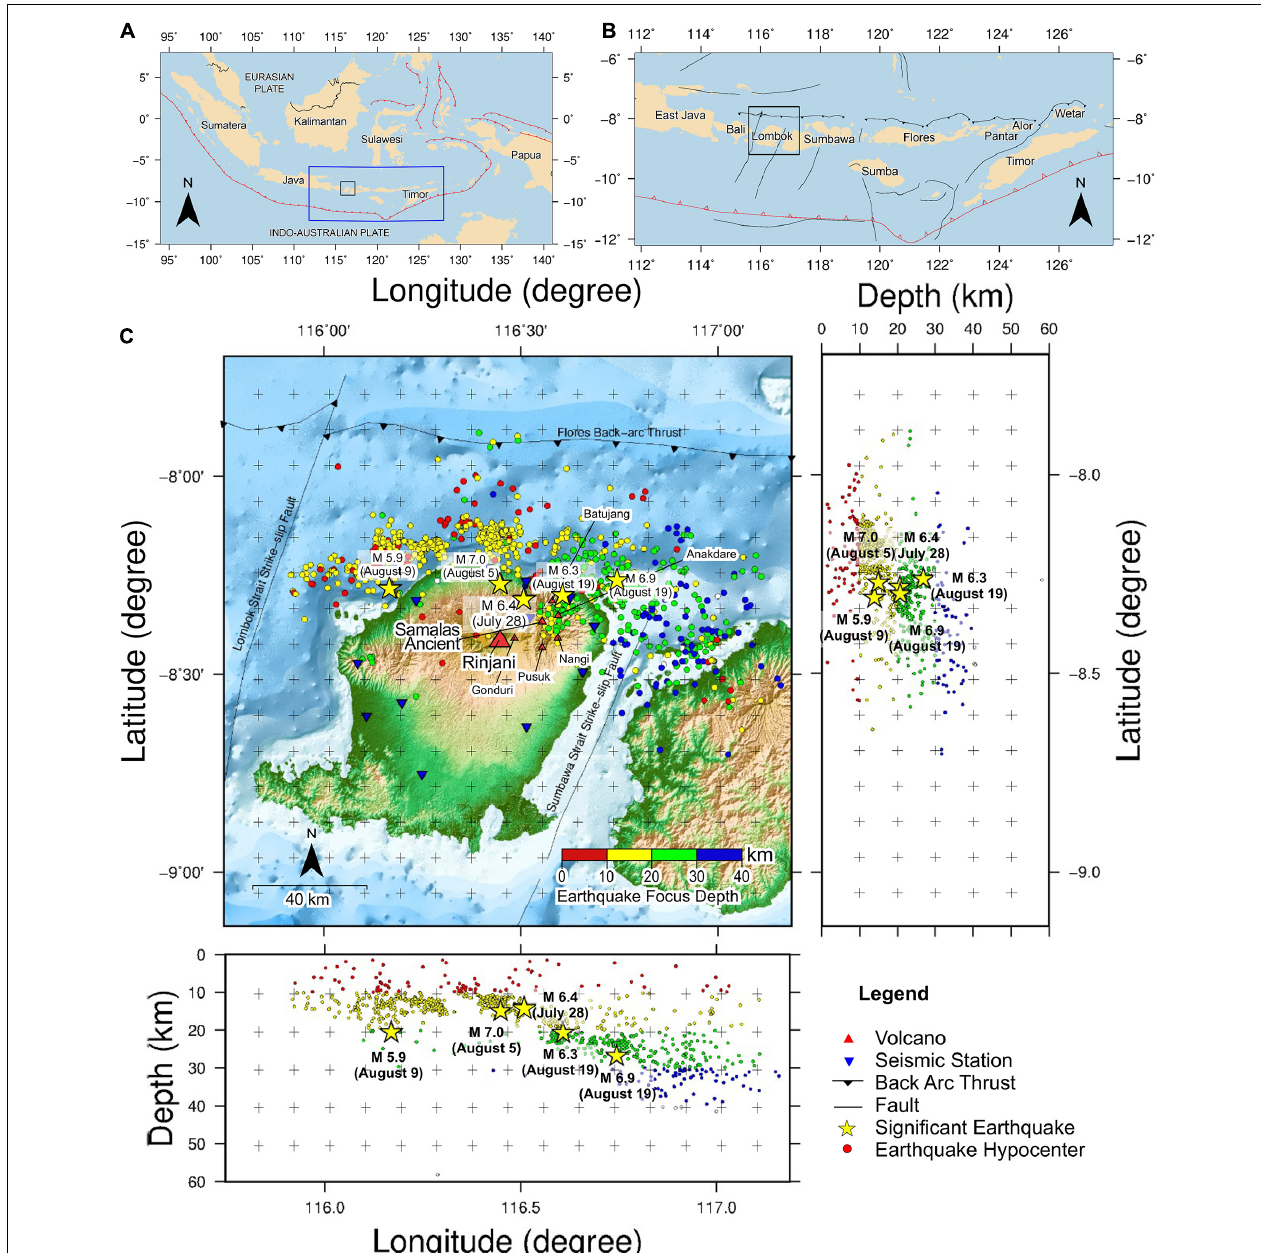
FIGURE 1 | (A) Map showing the major tectonic boundaries of Indonesia. The blue rectangle denotes the Lesser Sunda Islands and the black rectangle denotes the Lombok Island. The red jagged line denotes the subduction zone. (B) Map showing the Lesser Sunda Islands (from west to east): Bali, Lombok, Sumbawa, Flores, Sumba, Pantar, Alor, and Timor Island. The black jagged lines denote the back-arc thrust in the north of the islands and the black lines denote the faults (Irsyam et al., 2017; Afif et al., 2020). (C) Map of Lombok Island and the surrounding area which shows the distribution of the initial hypocenters from Afif et al. (2020). The hypocenters plotted here are the selected hypocenters from the spectral fitting process. The colored circle shows the depth of the earthquakes. The blue inverted triangles are the seismic stations, the big red triangle is the Rinjani volcano, the small red triangles are a group of volcanoes that are no longer active, and the yellow stars are the significant